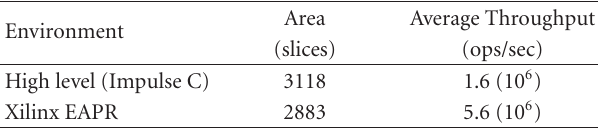
Table 3: Coprocessor application performance benchmarks.